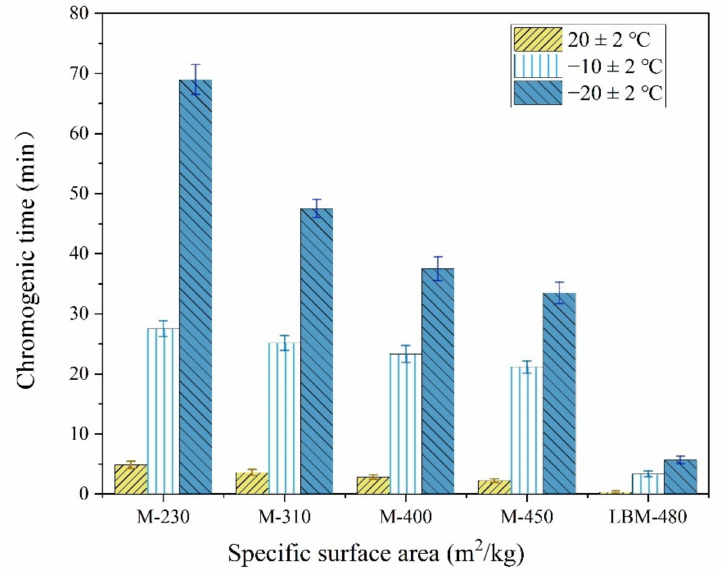
Figure 8. The chromogenic time of MgO determined by the citric acid